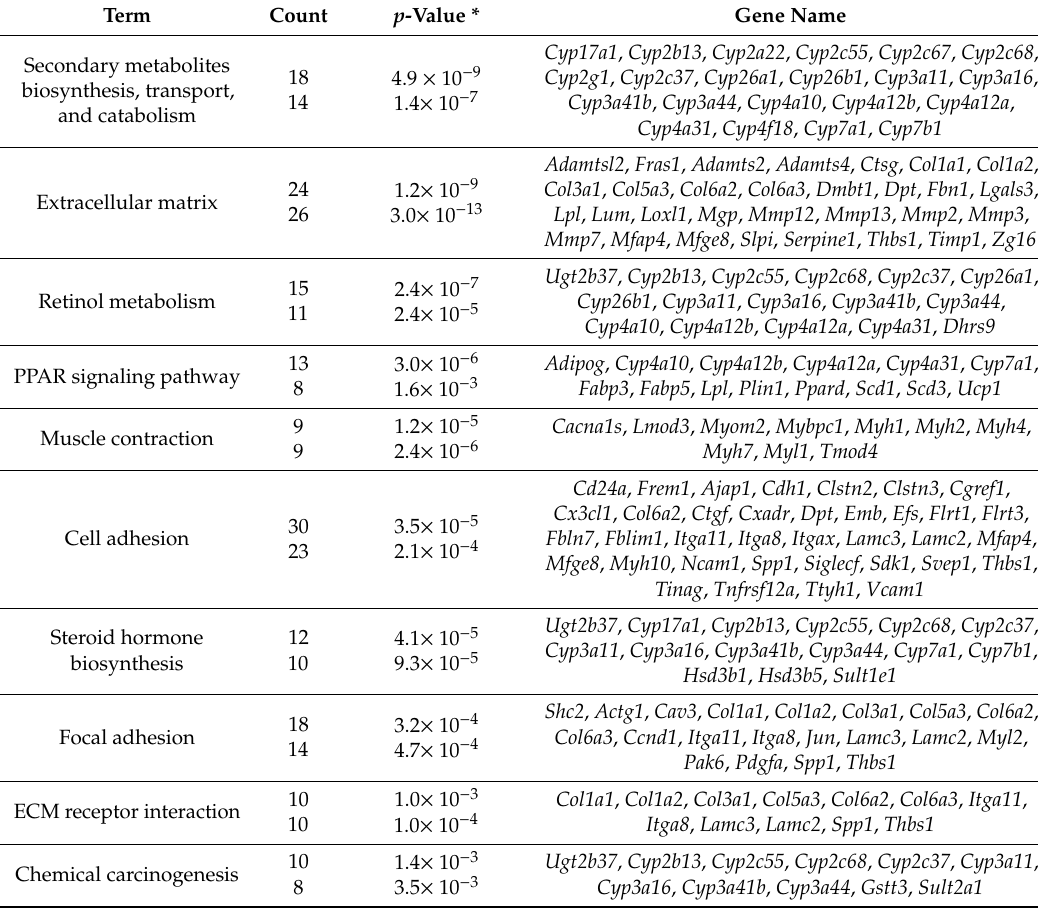
Table 1. Selected terms from functional annotation clustering of genes more than two-fold regulated in Abcb4 − / − and Abcb4 − / − / IL-13 − / − livers. p -Value